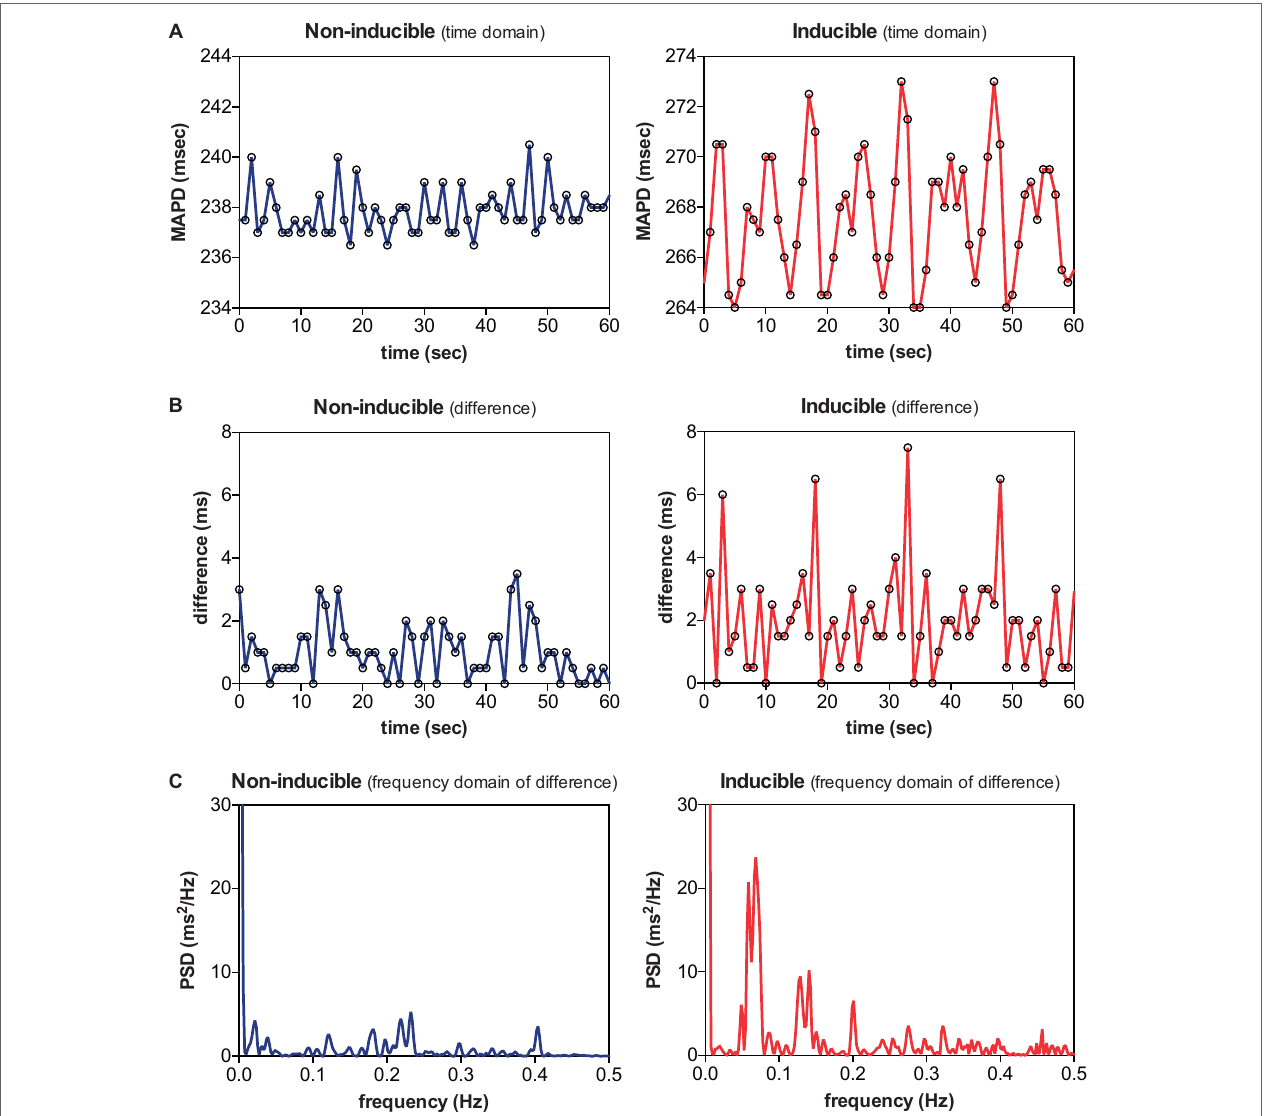
FIGURE 4 | Low-frequency (LF) oscillations in a non-inducible dog vs. an inducible dog. A representative example of MAPD (A) , MAPD difference in the time domain (B) , and MAPD difference in the frequency domain (C) of a non-inducible dog (left) and an inducible dog (right). A clear LF pattern in MAPD difference can be discerned in the inducible